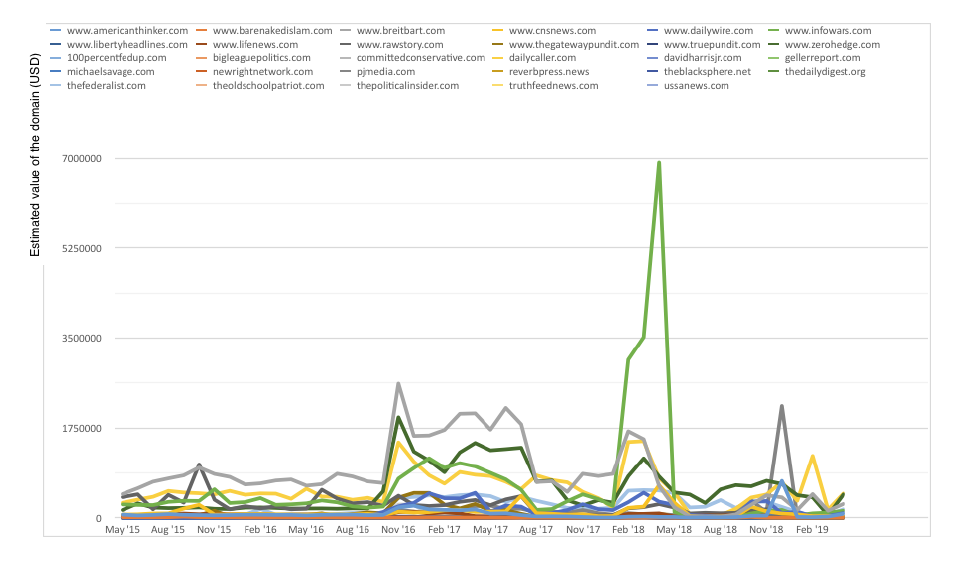
Figure 4: Estimated organic value for the top 29 junk news domains (May 2015 – March 2019)